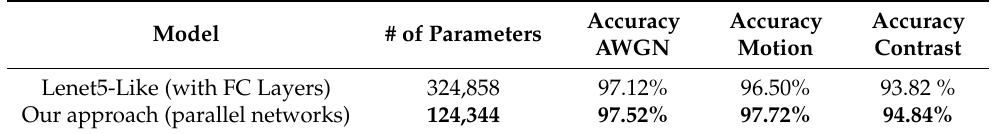
Table 5. Performance (accuracy) comparison between the Lenet-like architecture (with FC layers) and our hybrid Lenet–Hopfield architecture.